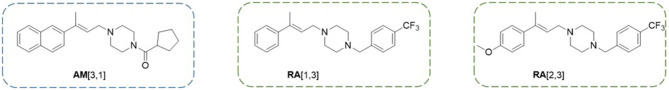
Structures of the three compounds emerged as the most interesting for their promising anticancer profile.